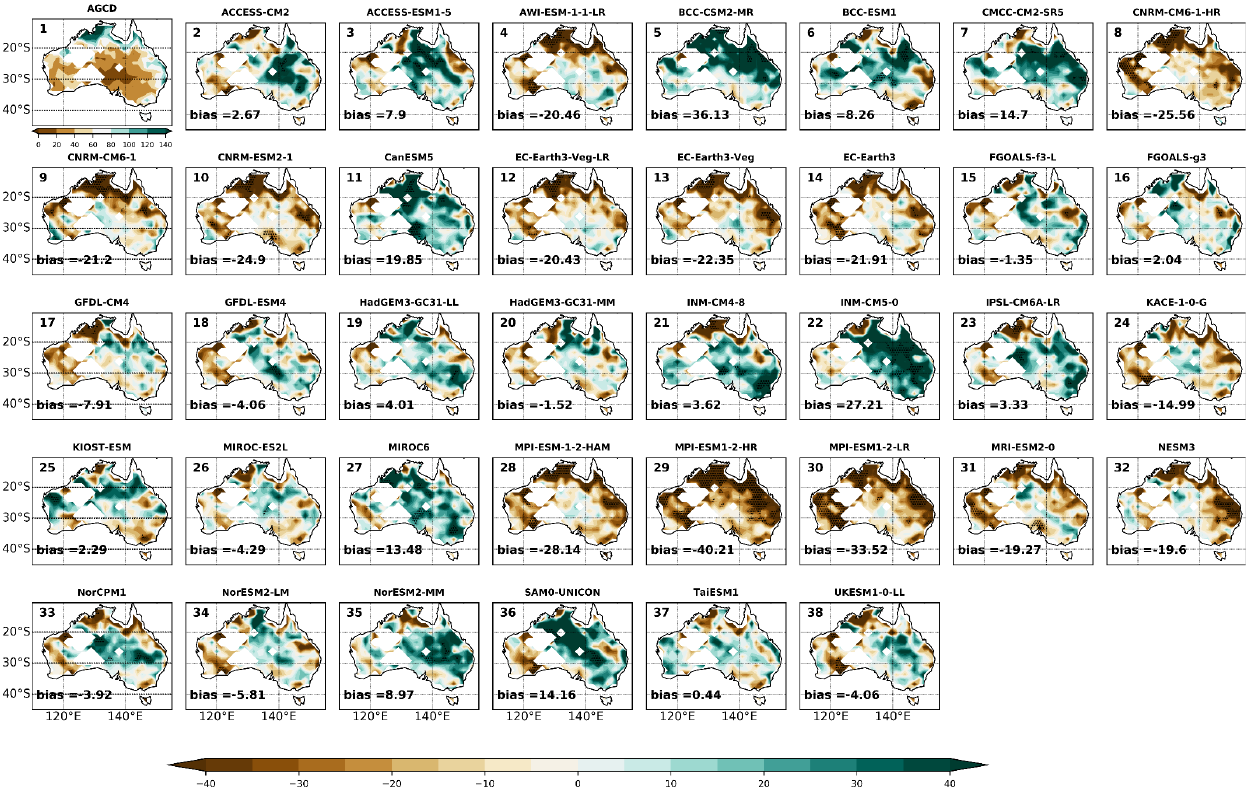
Figure 1. Climatological mean annual bias in total annual precipitation from very heavy rain days (R99p: mm) relative to the Australian Gridded Climate Data dataset (AGCD; panel 1 ) for the individual CMIP6 GCMs (panels 2 – 38 ). Data spans 1951—2014. Stippling indicates statistically significant differences using a student’s t-test at the 95% confidence level. The white masks in part of the inland domain are the regions with no station data.